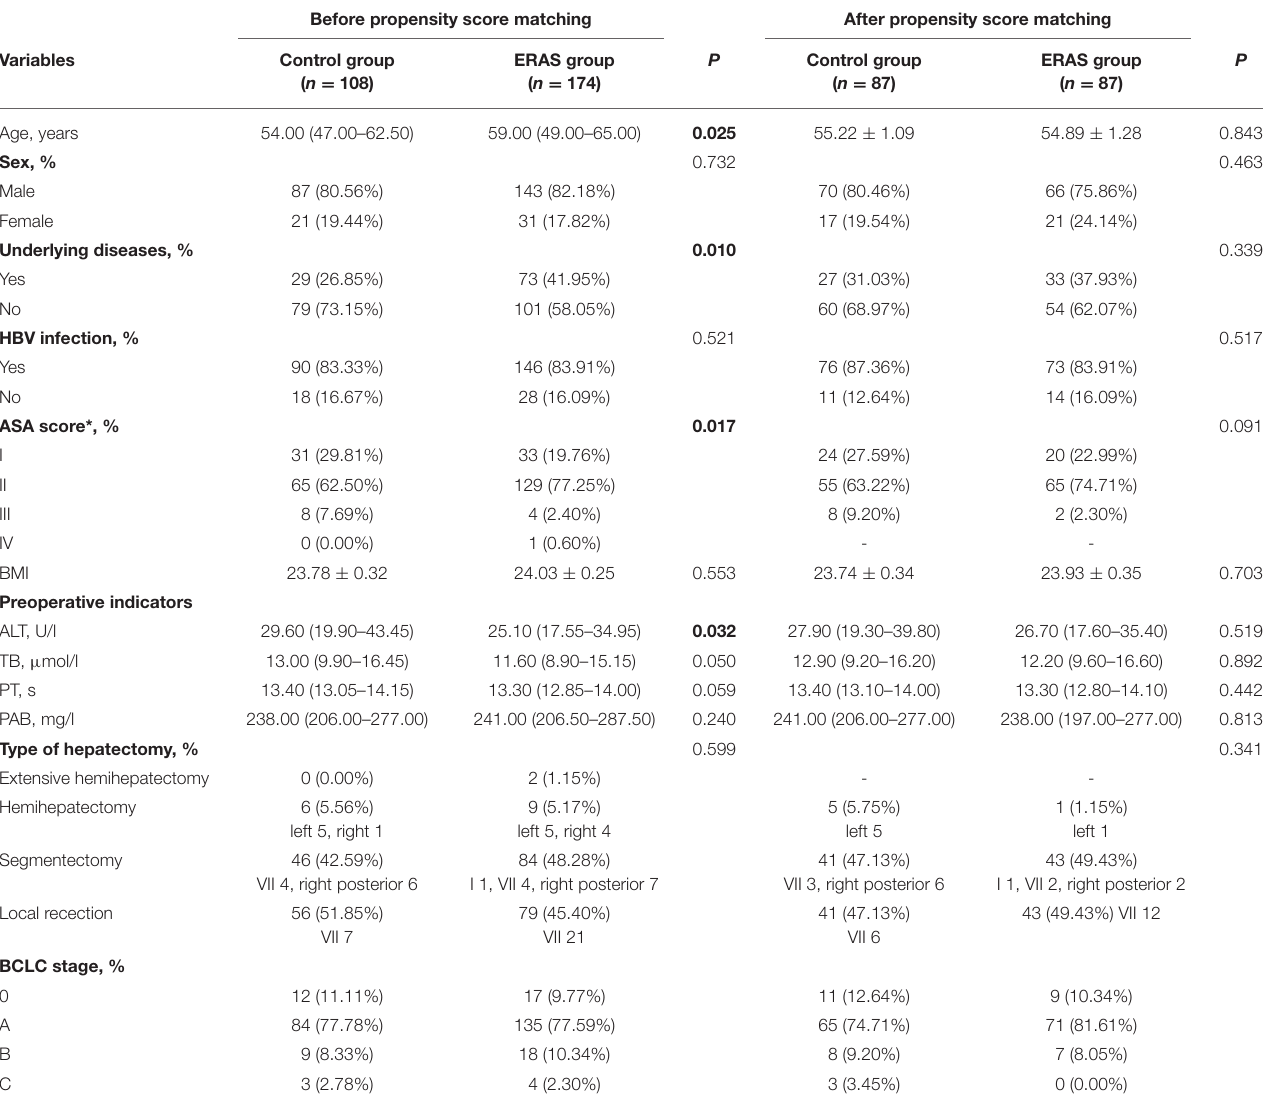
TABLE 2 | The clinicopathological characteristics of